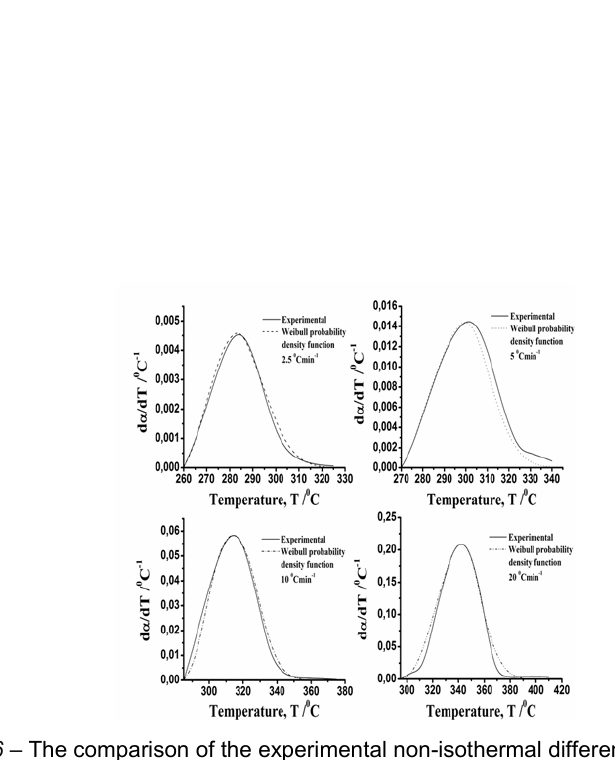
Figure 6 – The comparison of the experimental non-isothermal differential conversion curves and the Weibull probability density functions (Wpdf’s) at different heating rates, for the reduction process of NiO using hydrogen Slika 6 – Pore đ enje eksperimentalnih neizotermnih diferencijalnih konverzionih krivih i Vejbulovih funkcija gustina verovatno ć e (Wpdf’s) na razli č itim brzinama zagrevanja, za proces redukcije NiO koriš ć enjem vodonika